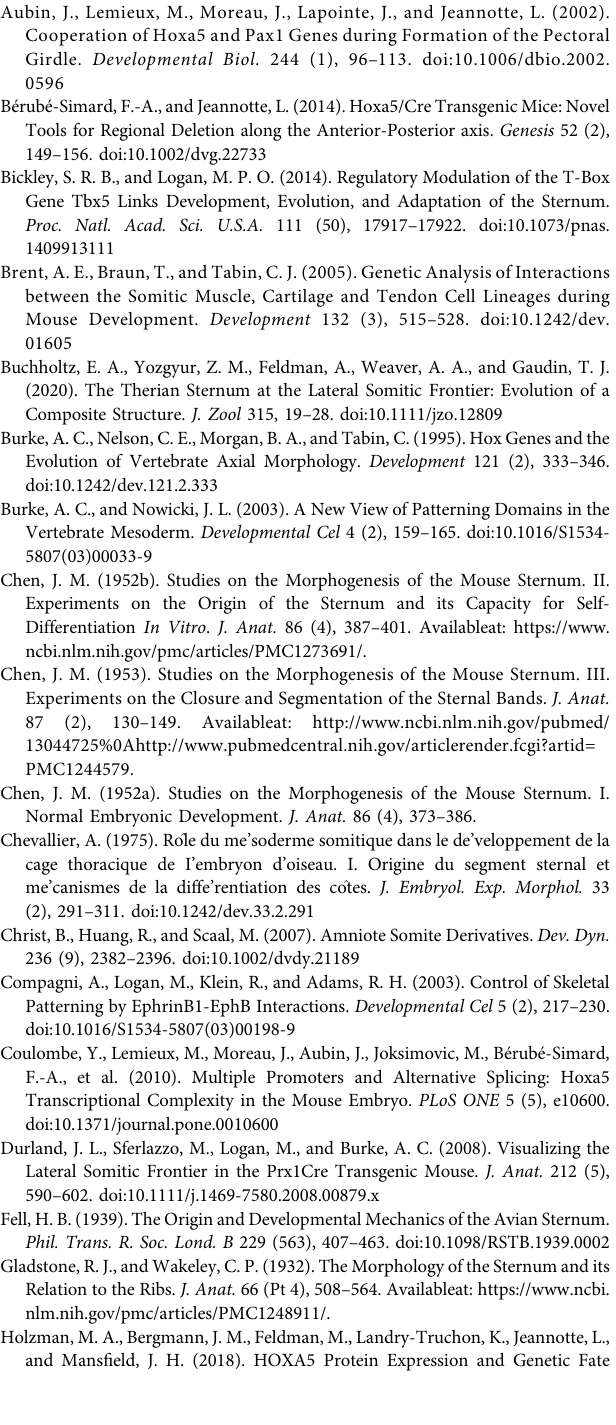
Supplementary Figure 6 | Lateral HOXA5 domain co-expresses EBF3, but not Tenascin. (A – A ‴ ) E14.5 embryo co-labelled for muscle Actin (blue, A ), HOXA5 (red, A ′ , A ‴ ), and Tenascin (green, A ′ , A ” ). HOXA5 and Tenascin are not co- expressed in lateral domain (A ′ ) . (B – B ‴ ) E14.5 Prx1-Cre-expressing embryo co- labelled for RFP (blue, B ), HOXA5 (red, B ′ , B ‴ ), and EBF3 (green, B ′ , B ’‘ ). HOXA5